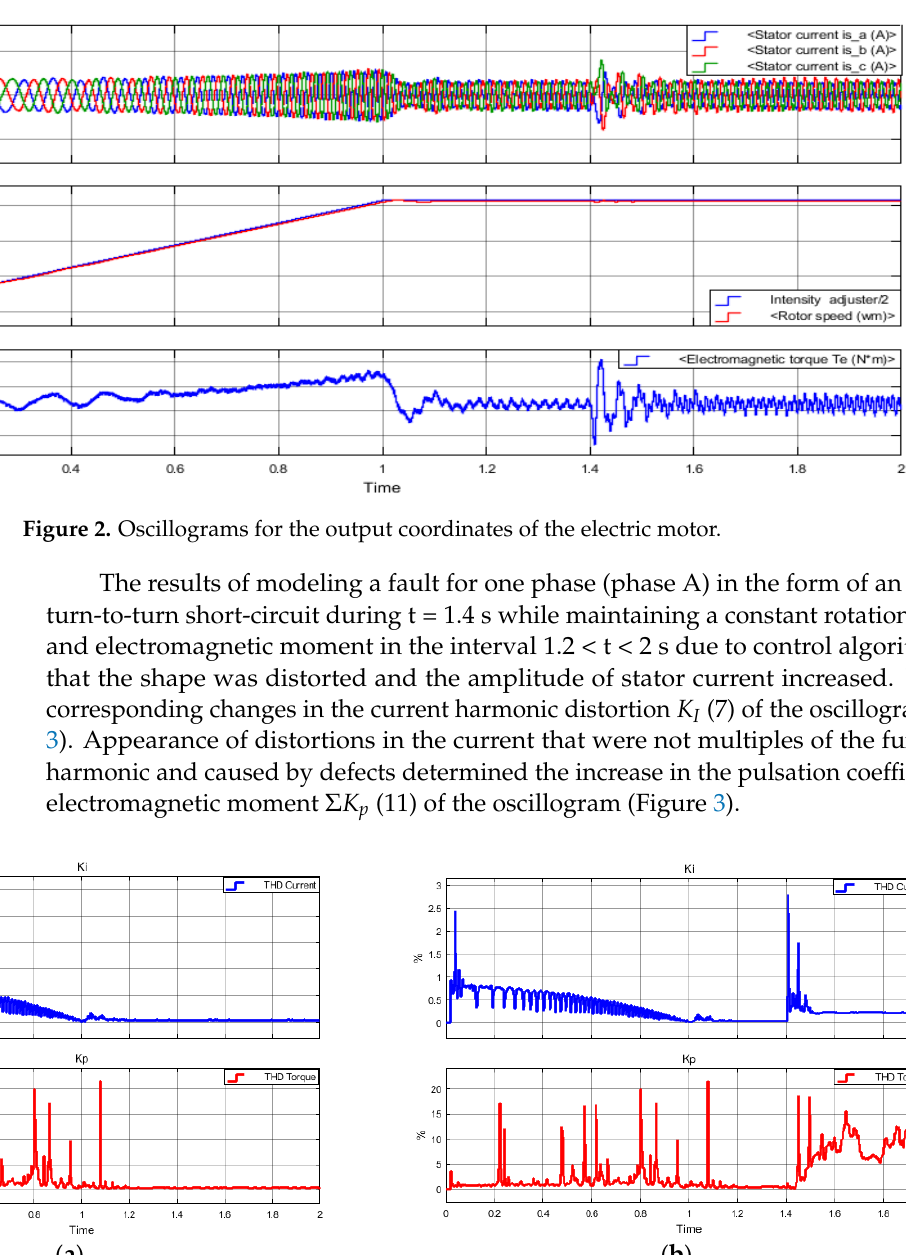
Figure 3. Changes in the harmonic distortion coefficient K I and the coefficient of pulsation of the electromagnetic moment Σ K p for AM: ( а ) in normal state; ( b ) with phase-to-phase short circuit for winding of stator (at t = 1.4 s).